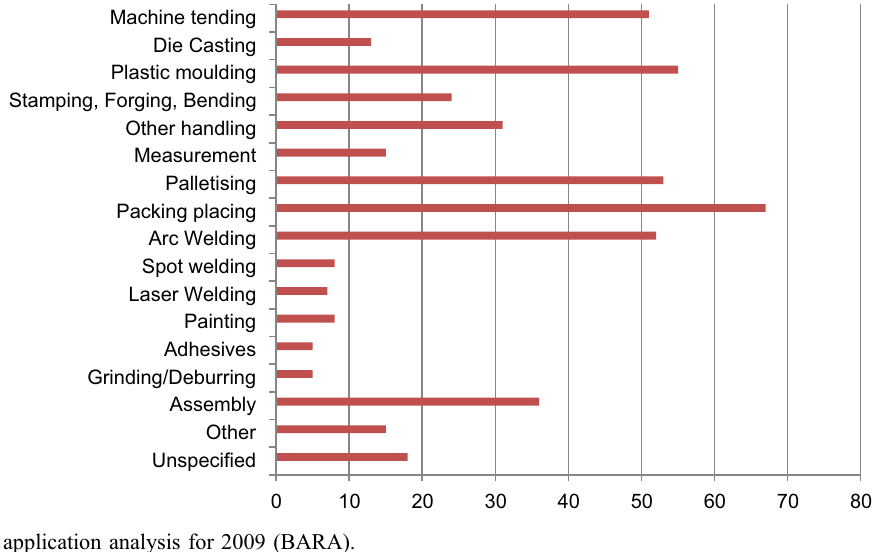
Figure 1. UK Robot application analysis for 2009 (BARA).